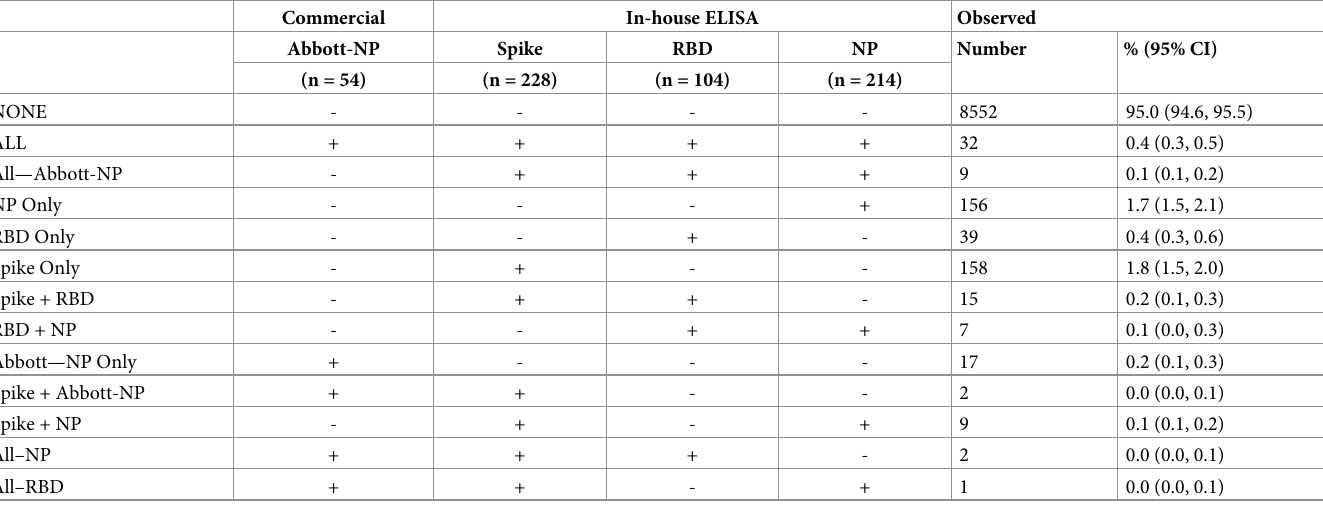
Table 2. Diagnostic phenotypes of anti-SARS-CoV-2 immunoassay results from 8999 samples tested.